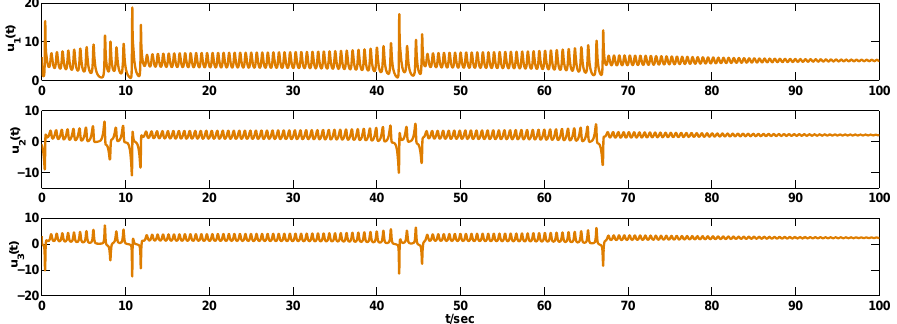
Figure 1. Time response of the states u 1 ( t ) , u 2 ( t ) , u 3 ( t ) of the drive system (13) with fractional order q = 0.828.